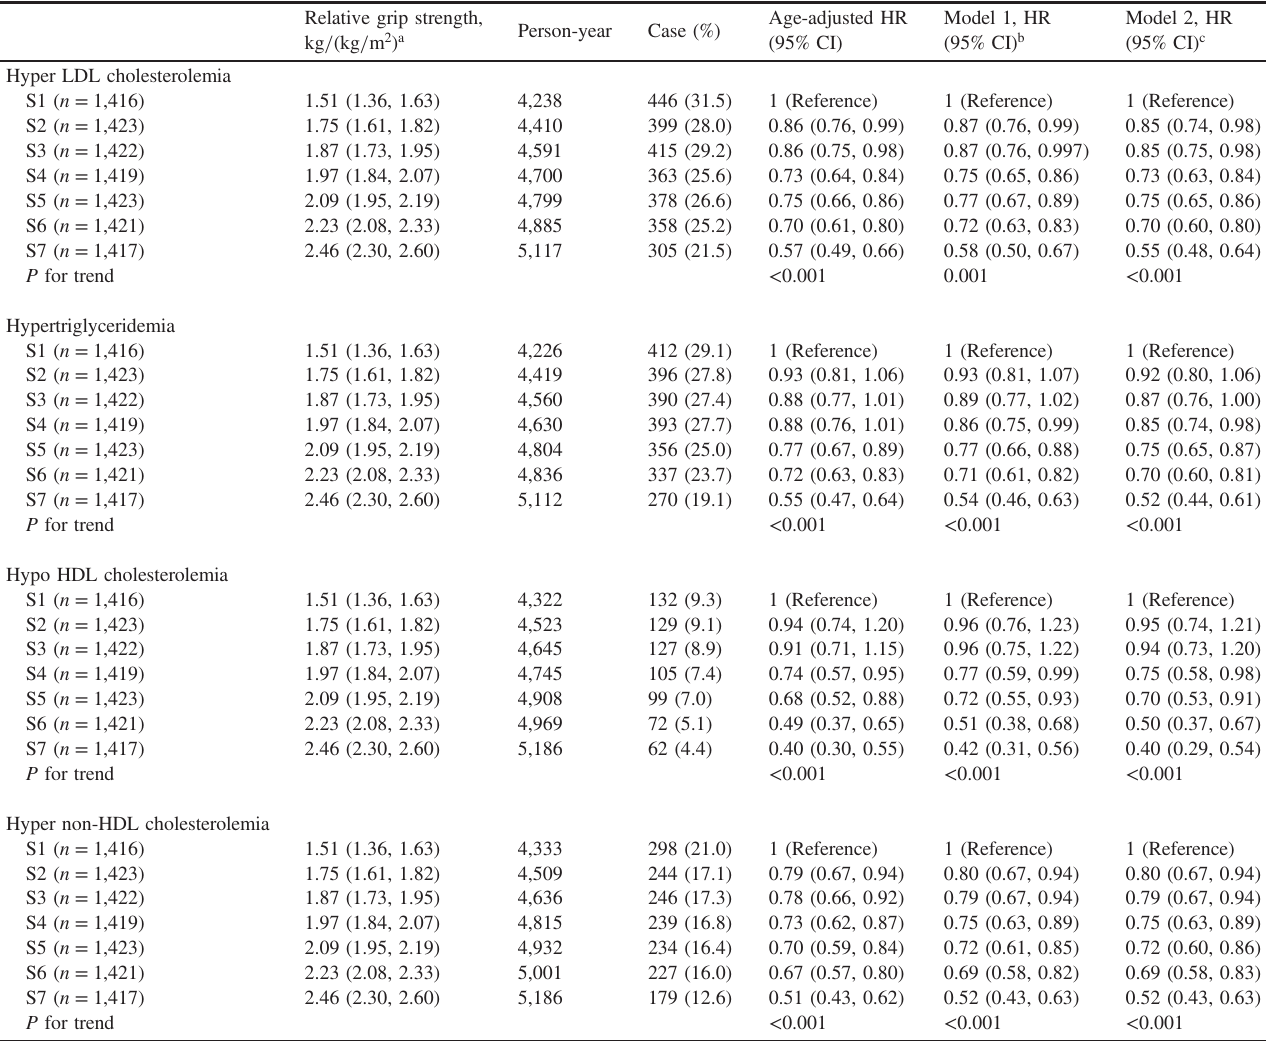
Table 3. Hazard ratios of the incidence of dyslipidemia ’ s components according to septiles of relative grip strength among men Relative grip strength, kg = (kg = m 2 )